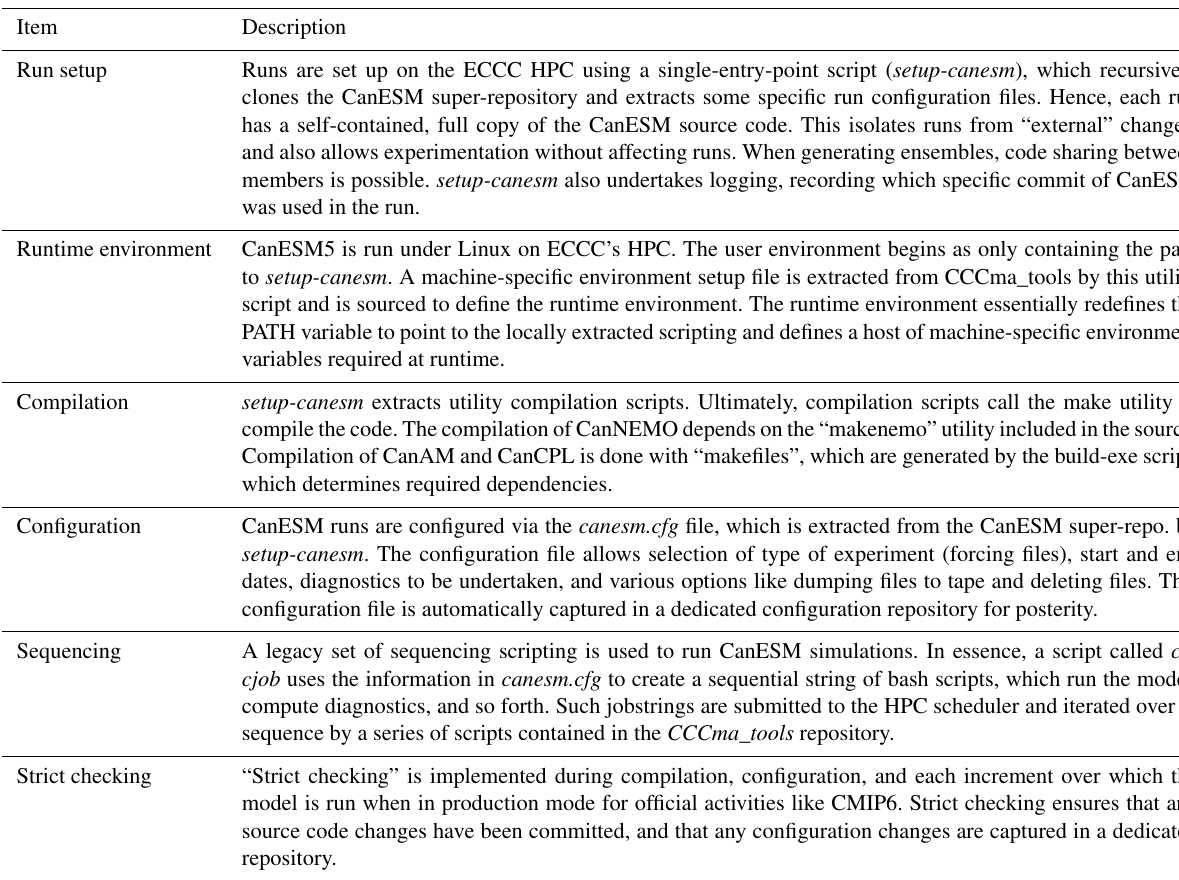
Table B2. Process for running